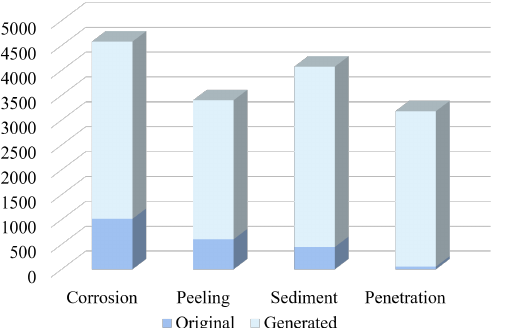
Figure 13. Distribution ratio graph of original and generated samples for each type of defect.